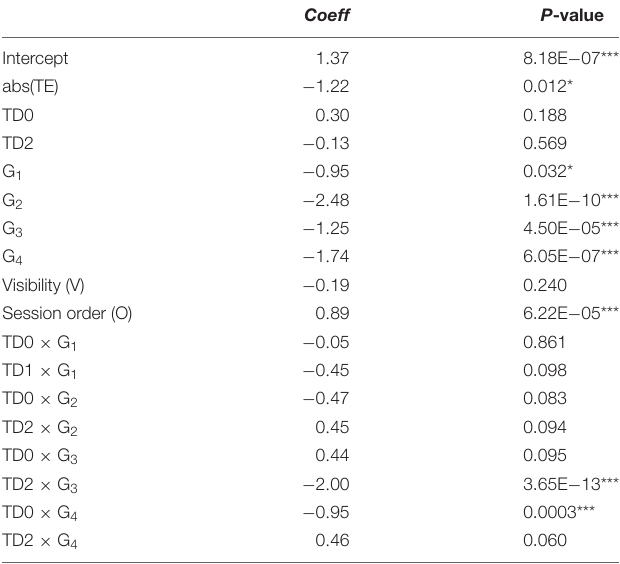
TABLE 3 | Correlation between perceptual and motor responses.